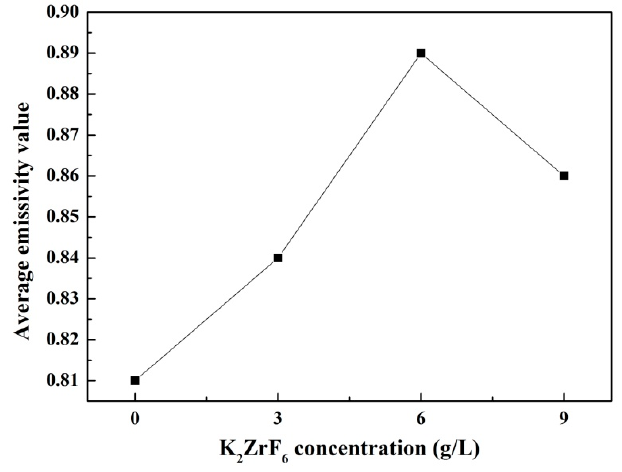
Figure 7. Average infrared emissivity curves of the MAO coatings under different K 2 ZrF 6 concentrations.